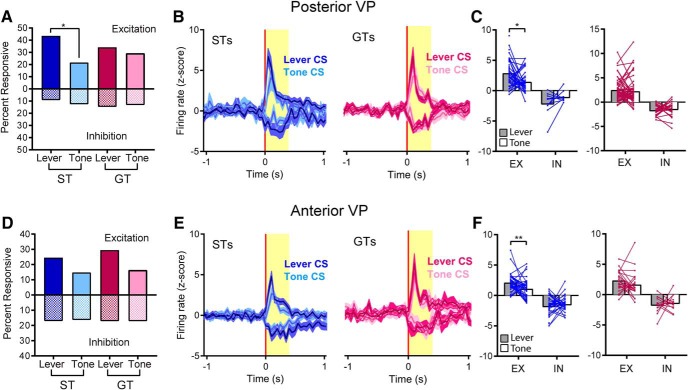
VP neurons showed immediate, phasic responses to the onset of lever and tone cues. Top figures represent cells from the posterior VP, and bottom figures represent cells from the anterior VP. A, In the posterior VP, responses to cue onset were largely excitatory. The percentage of cells that were responsive to cue onset did not differ between STs and GTs, although STs had significantly more excitatory cells in lever-CS trials than tone-CS trials (*, p < 0.05). B, Both excitatory and inhibitory responses to CS onset occurred within 0–400 ms and typically returned to baseline in <1 s. C, Responses to CS onset were examined within cells in lever-CS versus tone-CS trials for STs (left) and GTs (right). STs, but not GTs, showed significantly greater excitatory firing in lever-CS trials than tone-CS trials (*, p < 0.05; gray and white bars represent mean firing rate; EX, excitation; IN, inhibition). D, In the anterior VP, there were no significant differences in the proportion of responsive cells. E, F, Firing to CS onset was brief and immediate (E), and for STs (left), but not GTs (right), excitatory responses were significantly greater in lever-CS trials than tone-CS trials (F; **, p < 0.01).